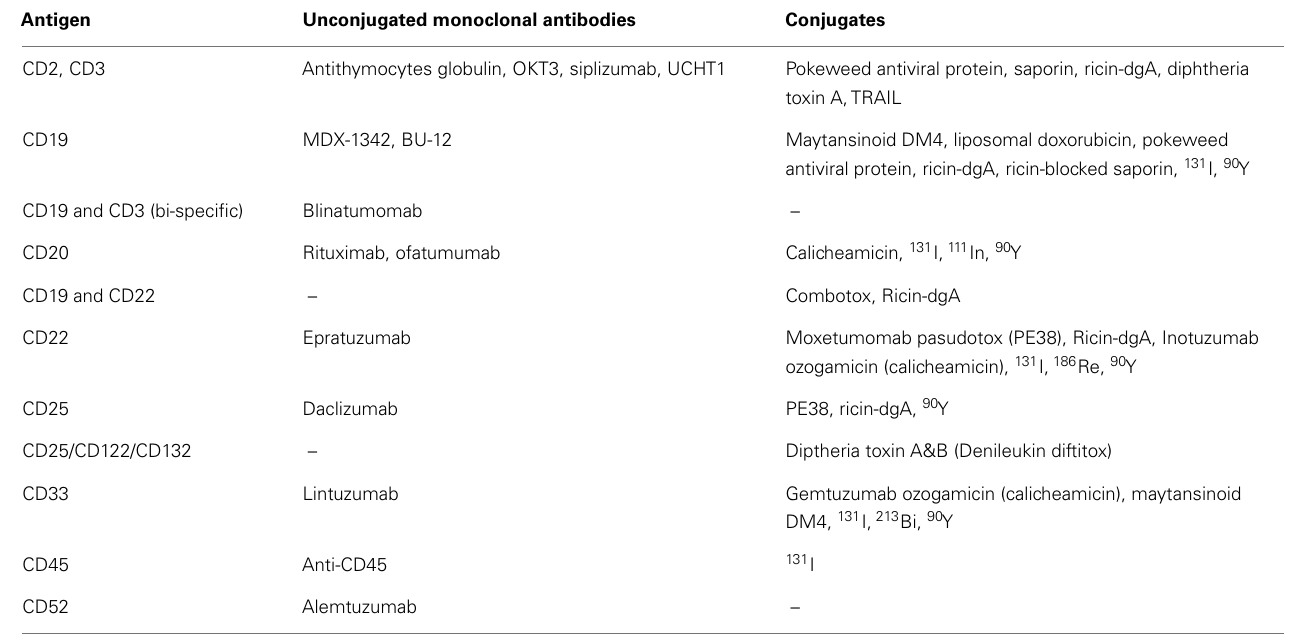
Table 1 | Monoclonal antibodies and